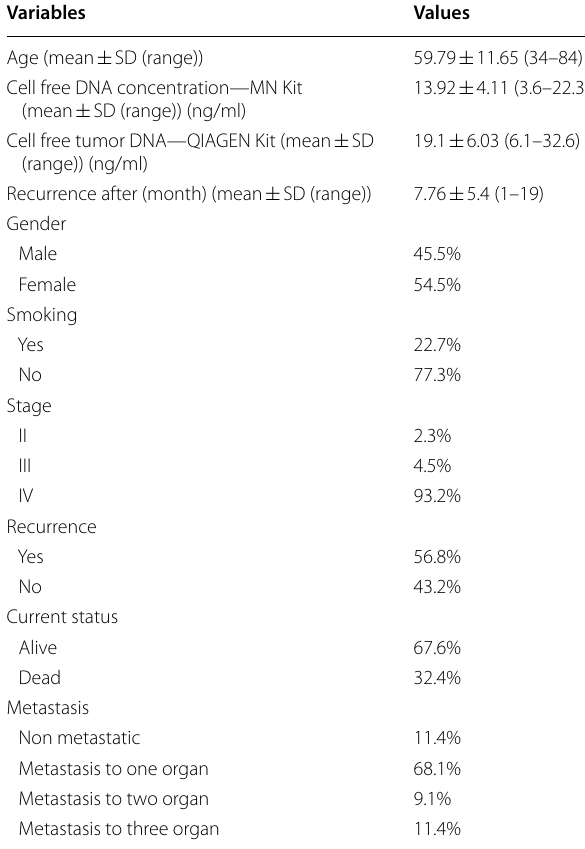
Table 1 General demographic and clinical data of patients Variables